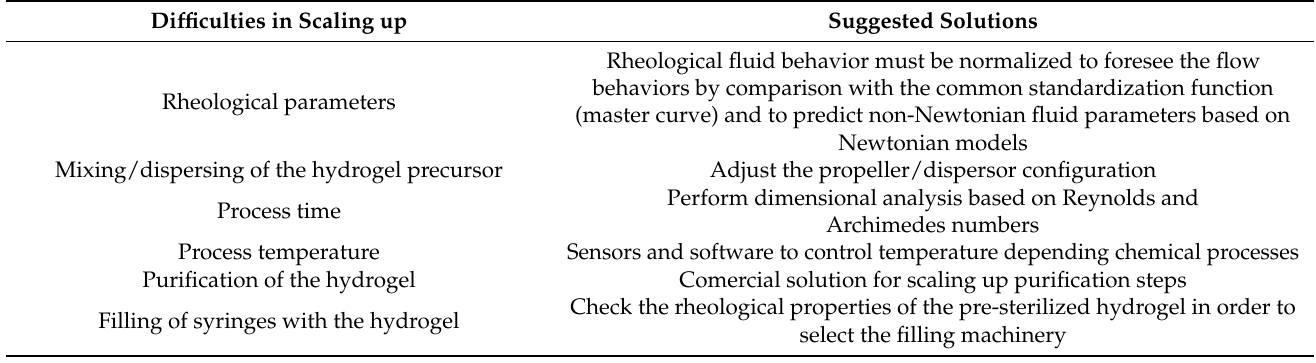
Table 2. Difficulties and solution for scaling up the fabrication of injectable hydrogels. Difficulties in Scaling